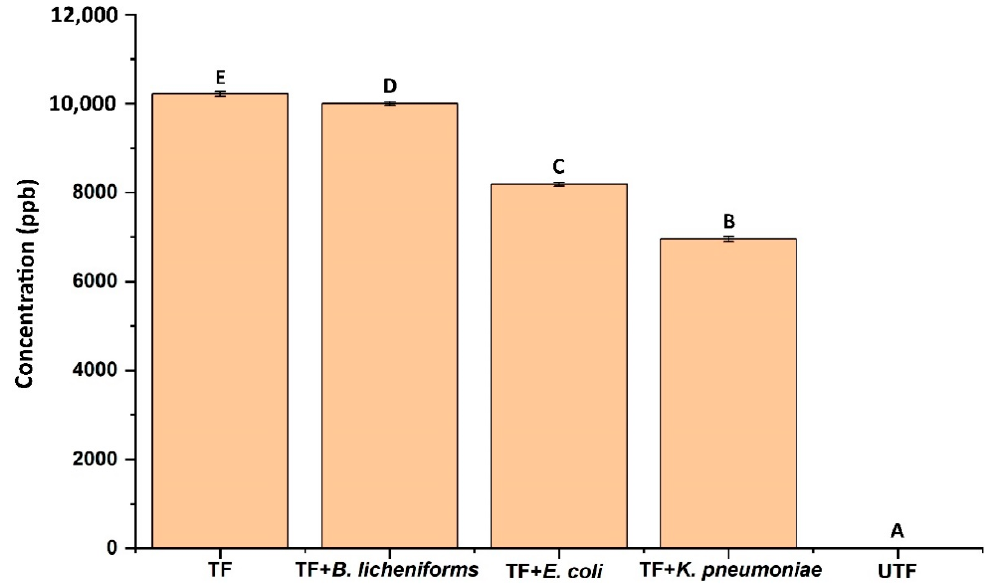
Figure 7. Concentration of AgNP detected in the culture broth treated with different test bacteria. TF denotes treated fabric and UTF denotes untreated fabric. Bars having different alphabet letters are statistically different.